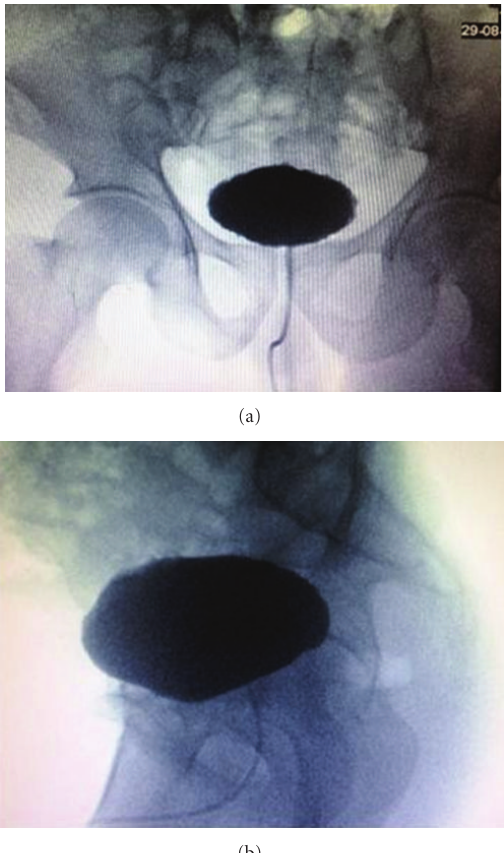
Figure 5: Retrograde cystography showing no contrast extravasa- tion after 10 days of the